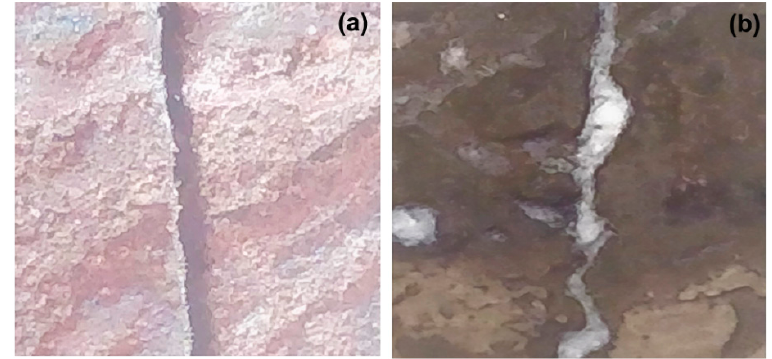
Figure 15. Snapshots of sample S4 ( a ) before ( b ) after water-flow test.